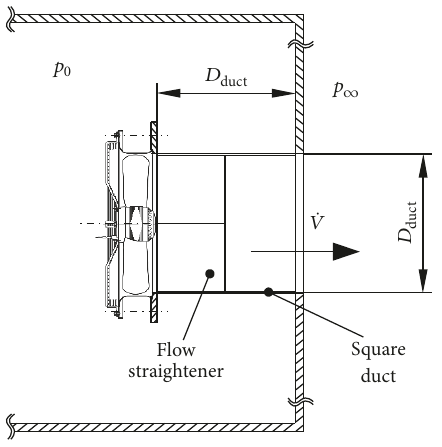
Figure 6: Standard fan test rig reference